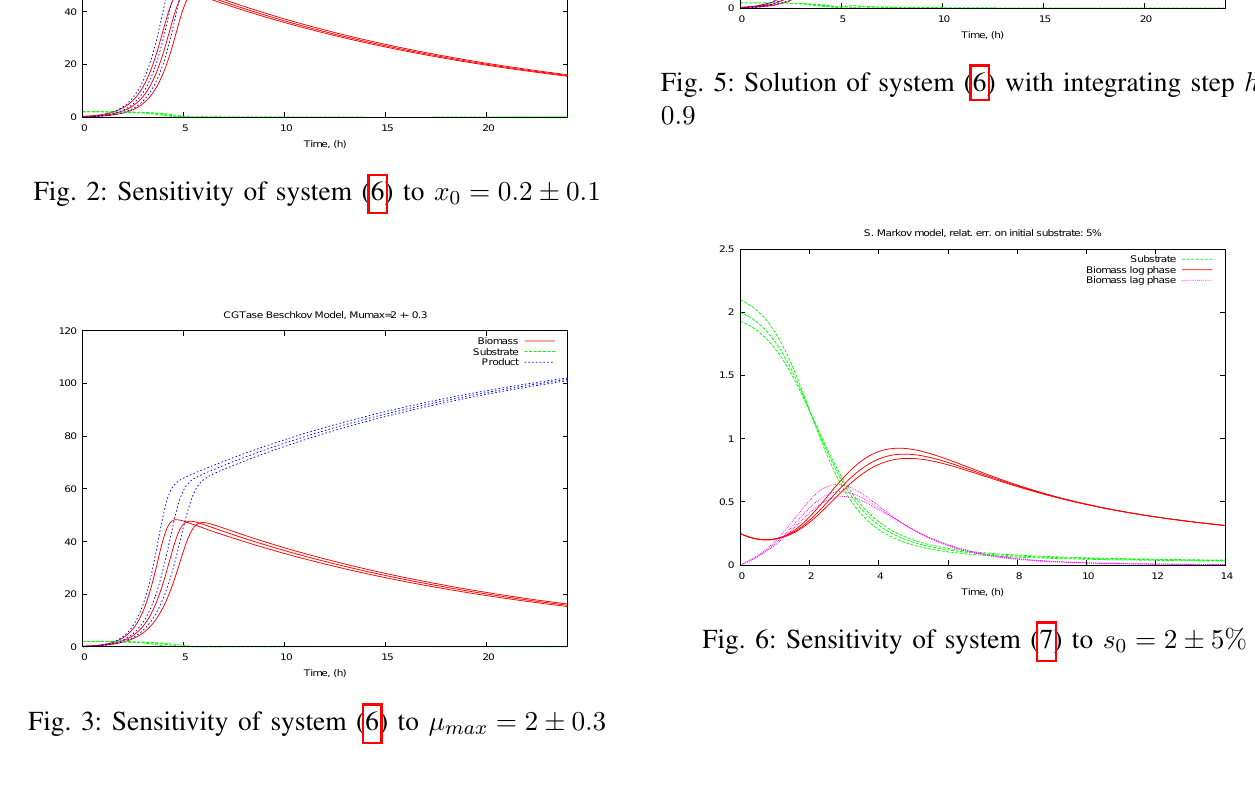
Fig. 3: Sensitivity of system (6) to µ max = 2 ± 0 . 3